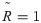
Sample convergence of fitness for a cluster of N = 16 nodes and R˜=1 radius.